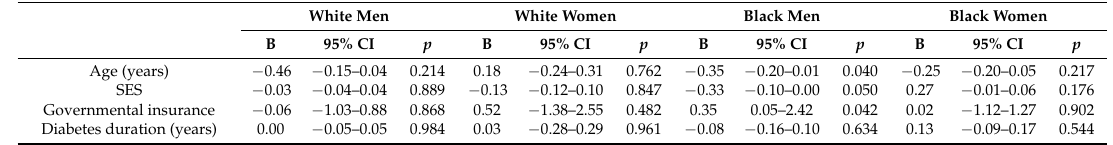
Table 4. Summary of linear regression stratified by race by gender